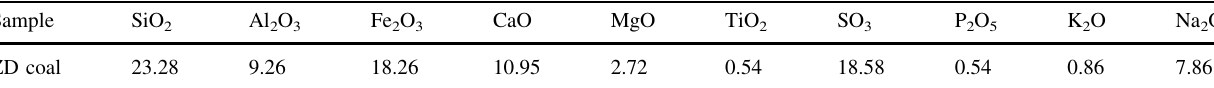
Table 2 Ash composition of ZD coal (wt/%) Sample